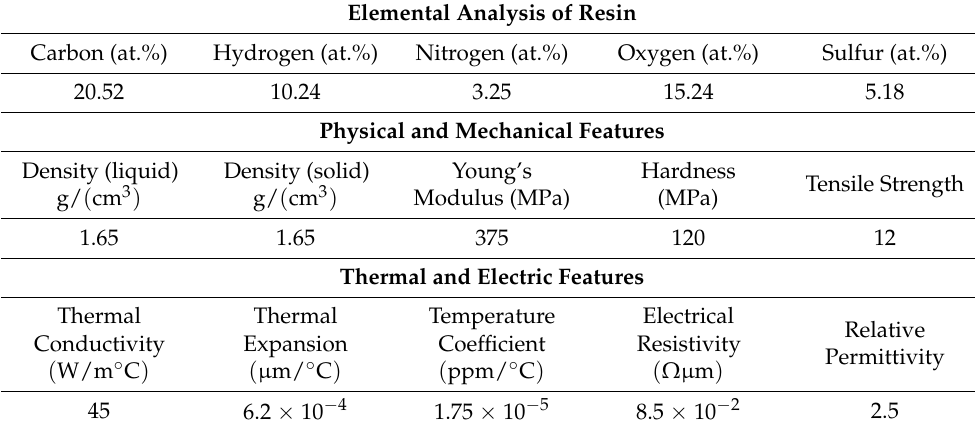
Elemental Analysis of Resin